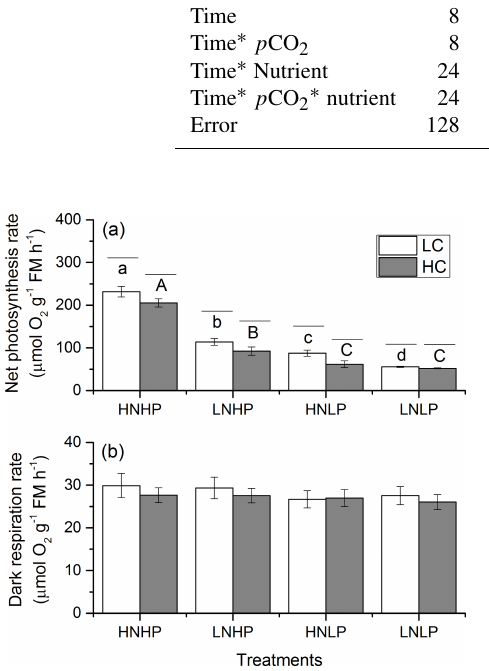
Figure 3. Net photosynthetic (a) and dark respiration (b) rates of adult U. linza grown under various conditions. LC, 400µatm; HC, 1000µatm; LN, 6.1µmolL − 1 ; LP, 0.2µmolL − 1 ; HN, 106.1µmolL − 1 ; HP, 10.2µmolL − 1 . The error bars indicate the standard deviations ( n = 3). Different letters (lower case for LC and capital for HC) above error bars represent significant differ- ences ( P < 0.05) among nutrient treatments while horizontal bars represent significant differences ( P < 0.05) between LC and HC within a nutrient treatment.